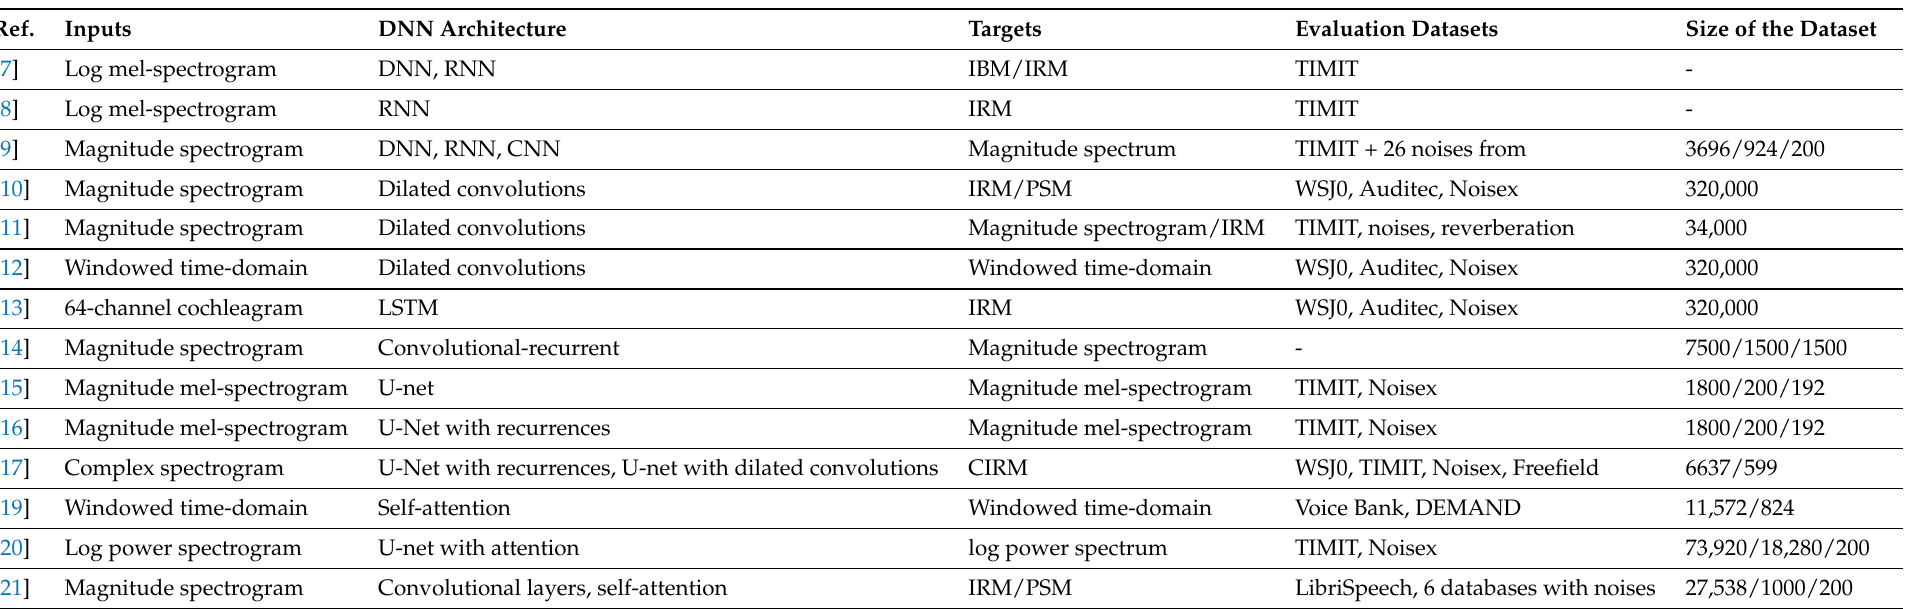
Table 1. Summary of DNN-based speech enhancement methods. In size of the dataset, if three values are provided, they mean the number of training, validation, and test utterances,